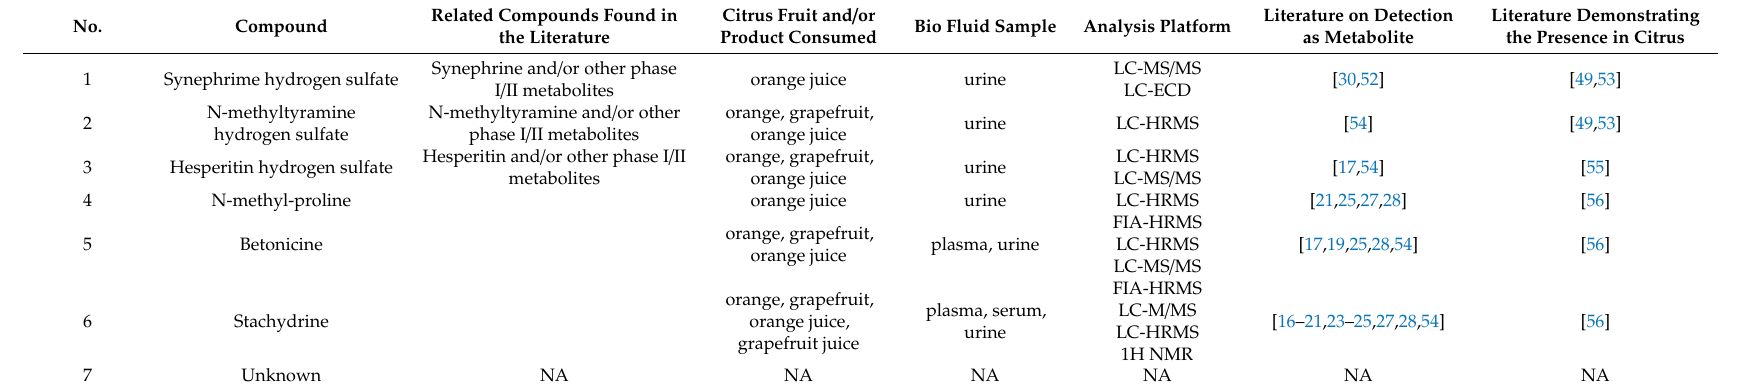
Table 3. Literature found on biomarkers related with the citrus